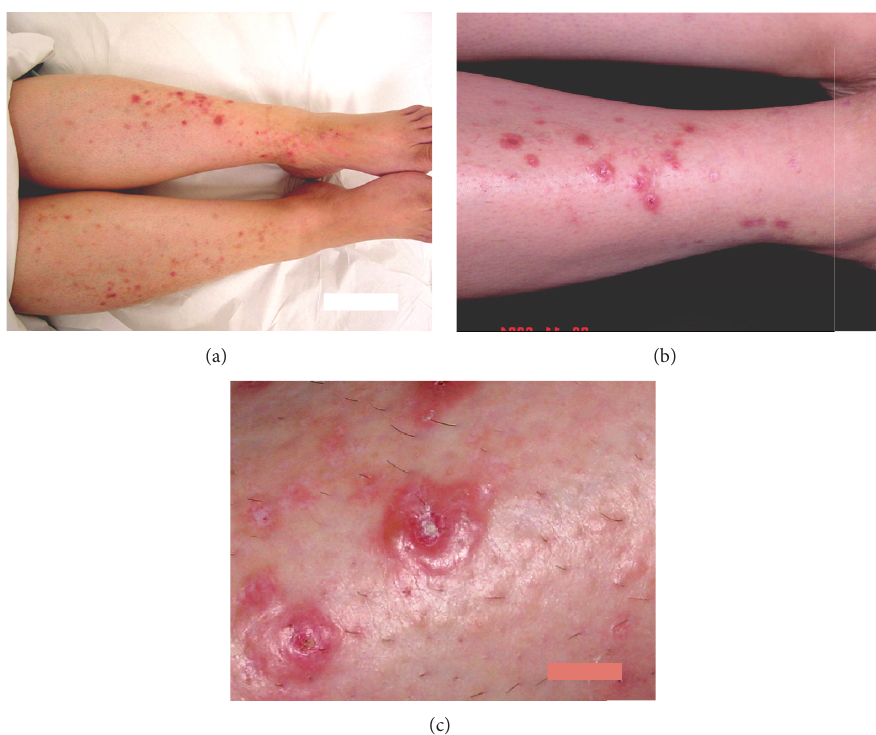
Figure 1: (a) The distribution of the lesions, bilateral and almost symmetrical, on both lower limbs. (b) Higher magnification showing the vesicular lesions lying on erythematous base and the fine white scars in healed lesions. (c) A close-up view of the vesicular lesions showing tense blistering with central crustations, on the right side of the photo a superficial white scar of healed lesion.